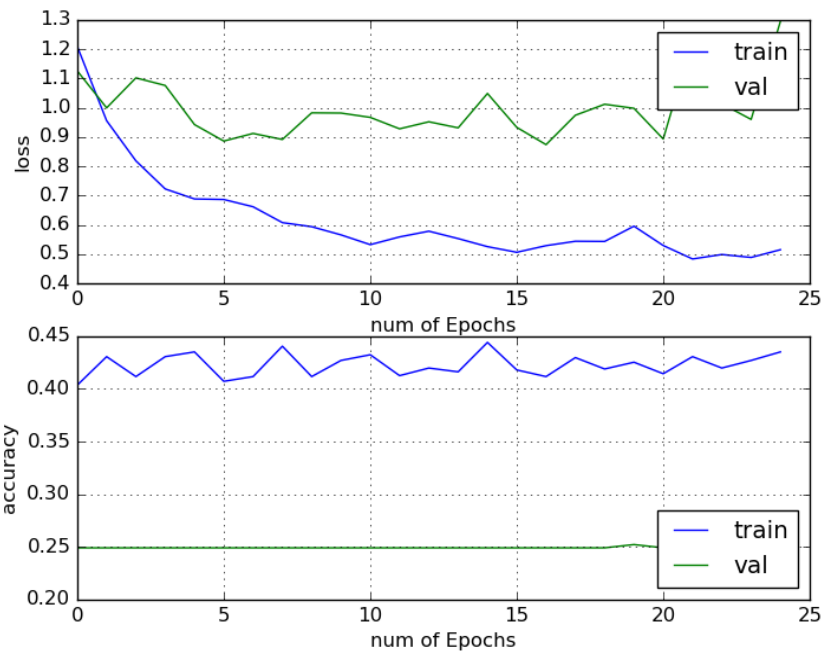
Figure 7. VGG-16 fine tune model on MLe2e using Adam